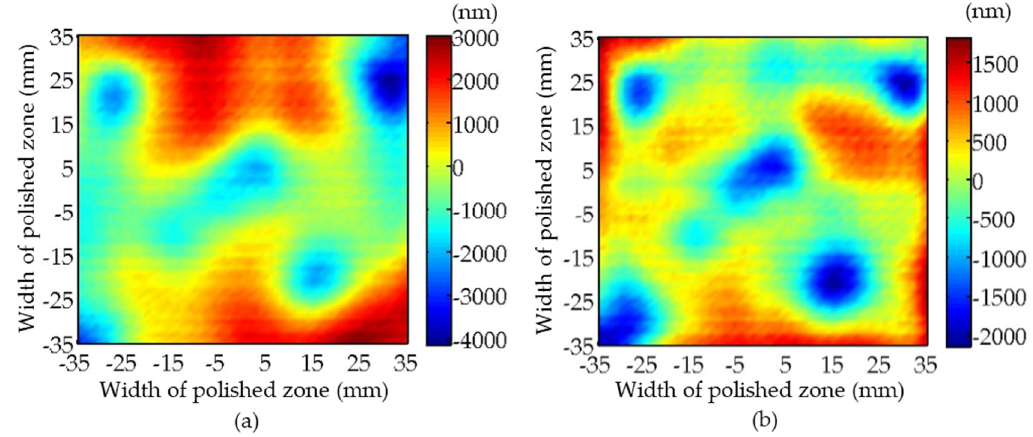
Figure 10. Changes in surface errors ( a ) before and ( b ) after conducting the proposed interpolation- based polishing.